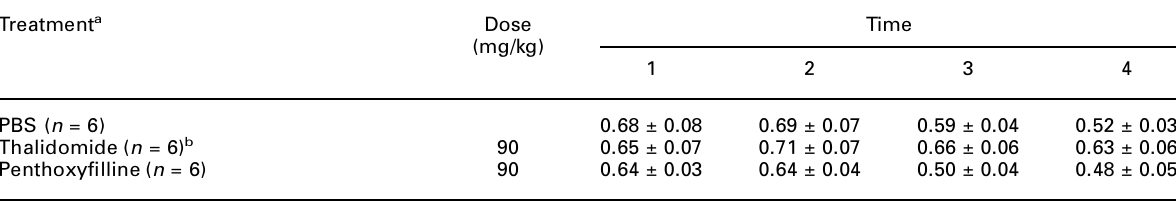
Table 3. Effect of anti-TNF drugs on the time-course of paw oedema induced by OVA in sensitized rats Treatment a Dose (mg/kg)